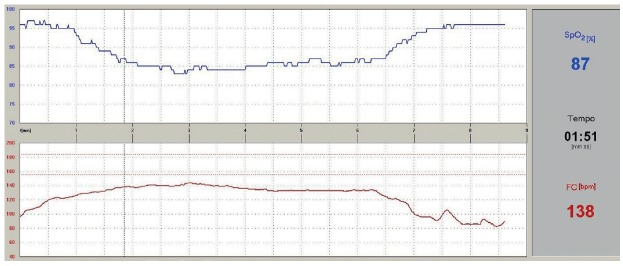
 Monitoramento da FC e da SpO2.